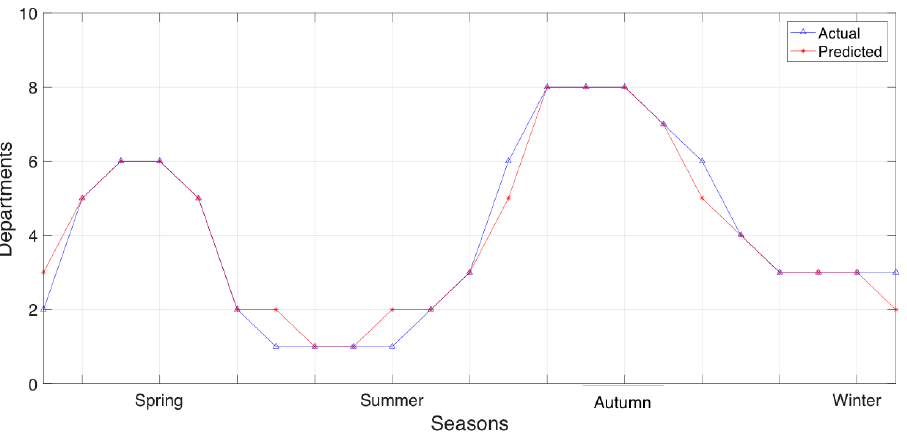
Figure 8. Actual and predicted distribution of municipality section Papagos department resource allocation per season.